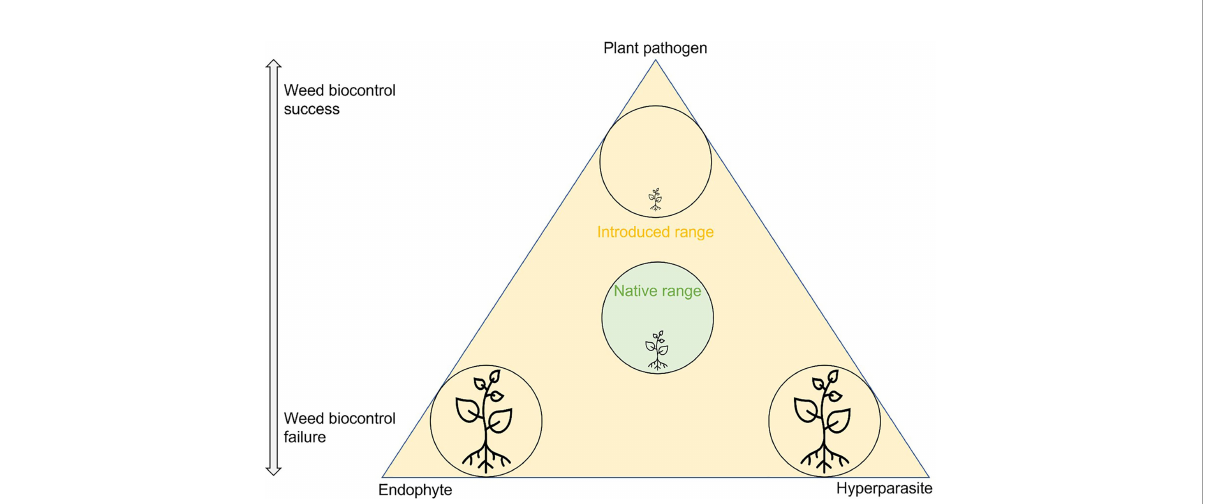
FIGURE 1 Schematic illustration of the interactions between plant pathogens and antagonists in the classical biocontrol of invasive plants. The plant, plant pathogen, and antagonist (endophyte and hyperparasite) are all potentially present in the environment. In the native range (in the green center of the triangle), the interactions are in balance, and the plant is non-invasive. In the introduced range (orange) the plant is present as an introduced exotic species. There are three scenarios: 1) The plant pathogen, introduced as a biocontrol agent, successfully suppresses the plant (top of the triangle). Its effect is stronger than that of any present endophytes or hyperparasites. 2) A protective endophyte inhibits the plant pathogen (bottom left of the triangle). Biocontrol fails, and the plant remains an invasive weed. 3) A hyperparasite inhibits the plant pathogen (bottom right of the triangle). Biocontrol fails, and the plant remains an invasive weed. Both lower parts of the triangle are examples where outbreaks of a plant pathogen have been prevented, either intentionally (biocontrol of pathogens) or unintentionally (interference with the biocontrol of